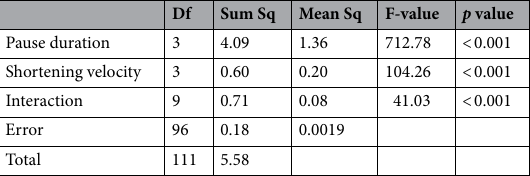
Table 1. Results of two-way ANOVA. Effects of pause duration (10, 20, 80 and 1000 ms) and shortening velocity (1/8, 1/2, and 2 L0/s) on relative muscle force.